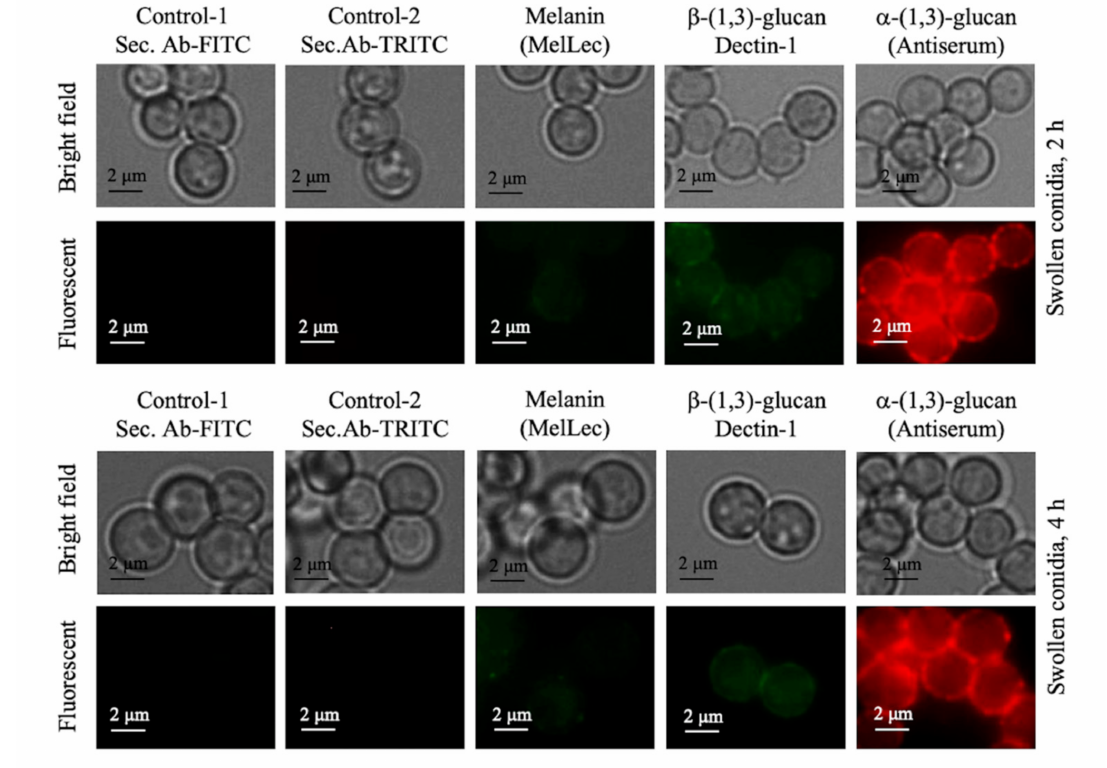
Figure 7. Swollen conidia (after 2 or 4 h of dormant conidial incubation in liquid culture medium) immunolabeled with MelLec, Dectin-1, and polyclonal anti- α -(1,3)-glucan-serum for melanin, β -(1,3)-glucan and α -(1,3)-glucan detection, respectively; the controls were swollen conidia treated with secondary antibodies [anti-human-IgG-FITC for MelLec / Dectin-1 (green), and anti-mouse-IgG-TRITC for α -(1,3)-glucan (in red)]. During the course of germination (from 2 to 4 h), there was a gradual decrease in the MelLec labeling, due to the disintegration of melanin pigments, while there was intensification of the labeling for α -(1,3)-glucan; although there was also intensification of the Dectin-1 labeling for β -(1,3)-glucan, the labeling was weak compared to that of α -(1,3)-glucan